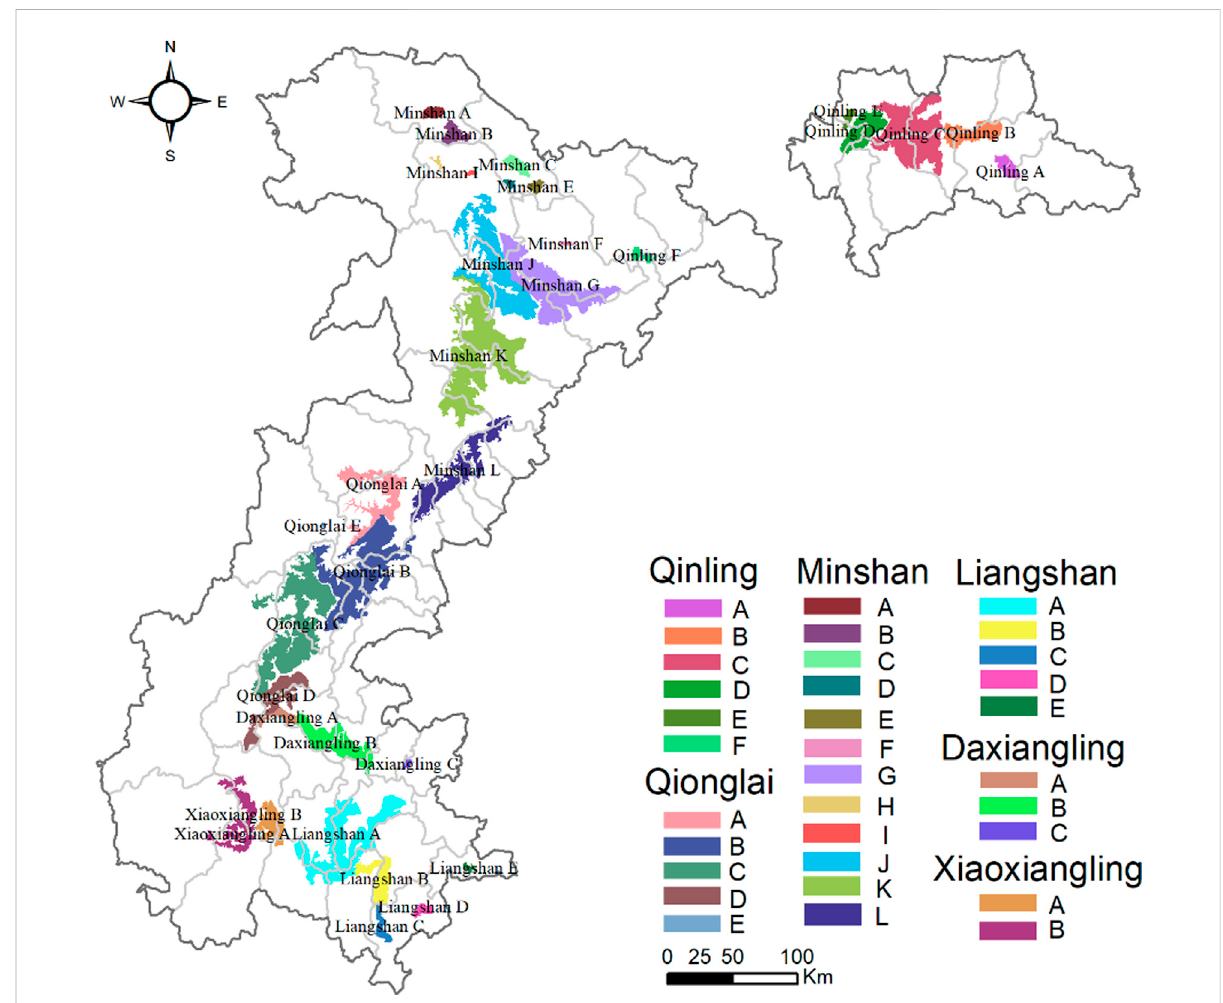
FIGURE 2 Wild giant panda populations (Forestry and Grassland Administration, 2021; Kong et al.,